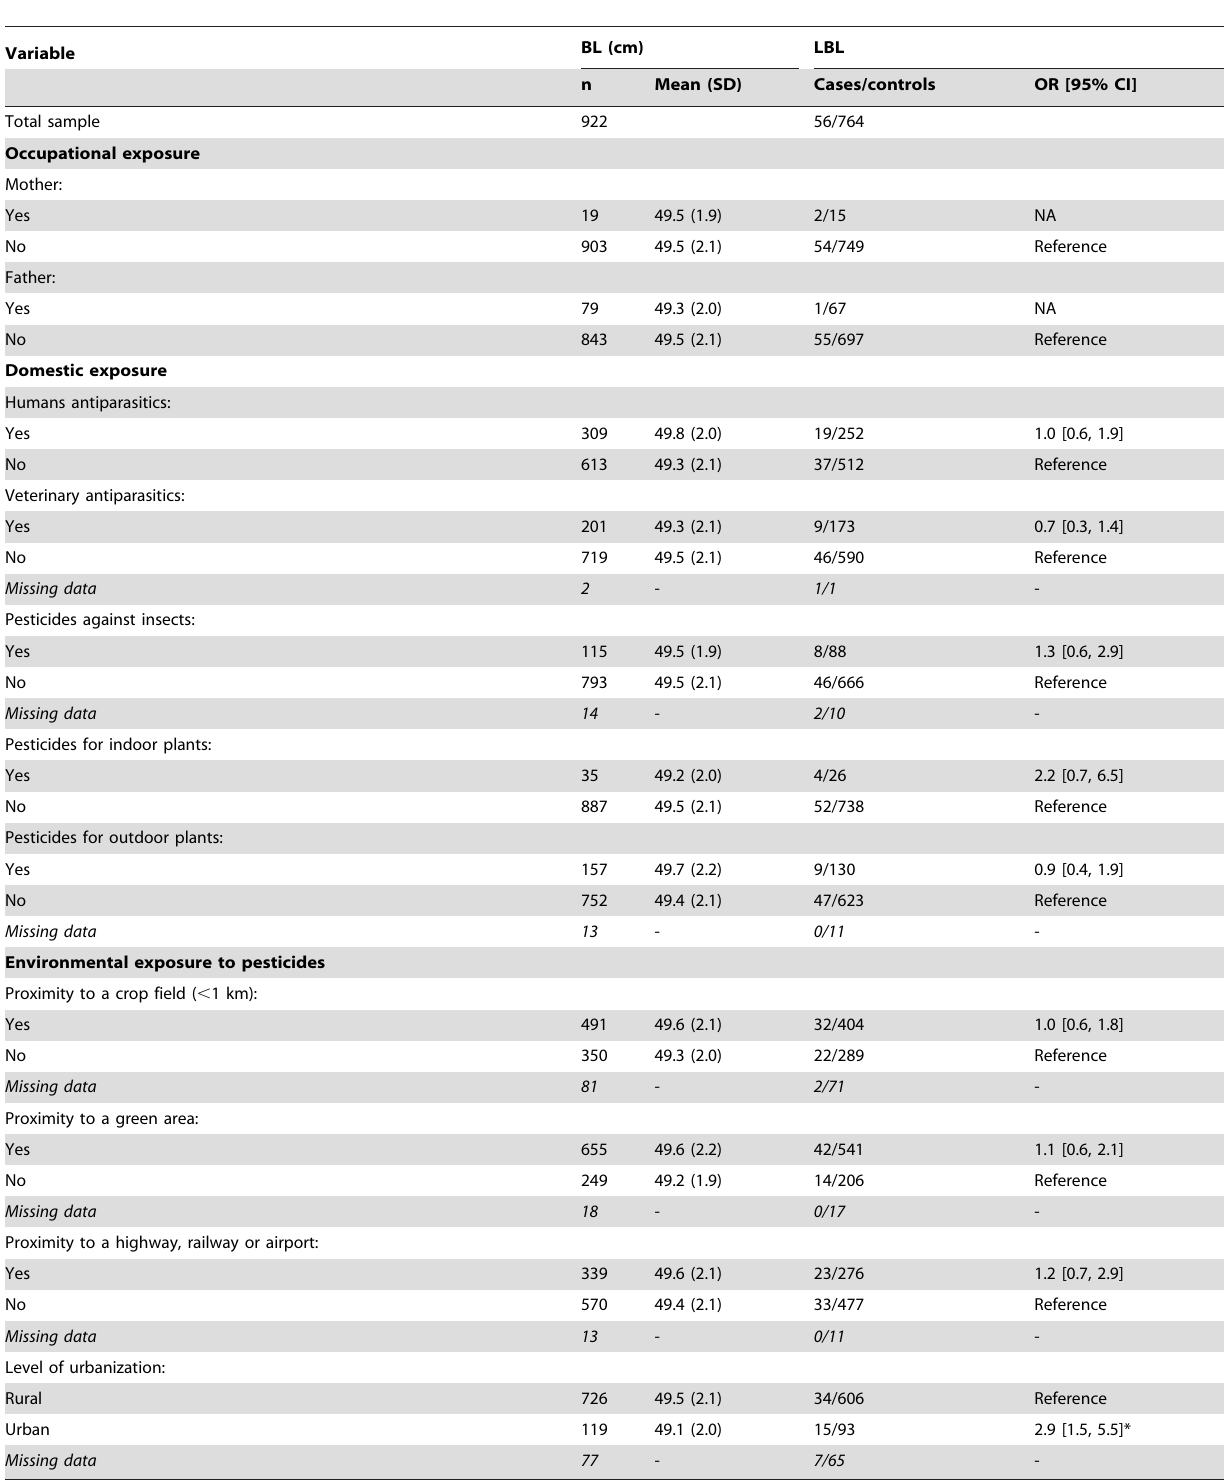
Table 9. Multivariate associations between (i) variables related to in utero exposure to pesticides, (ii) birth length (BL, in cm) and low birth